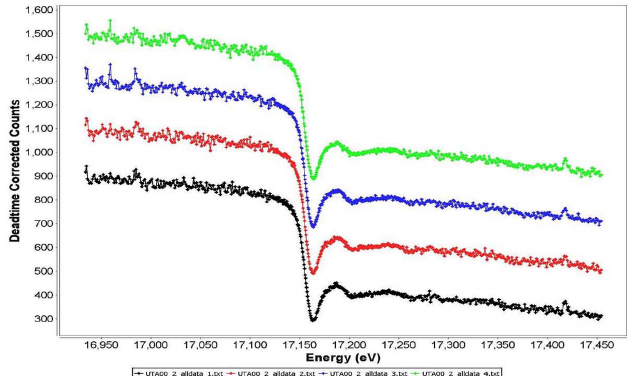
Figure 2 Example of the HERMES plotting window, showing a stack plot of I t data at the U L 3 -edge, separated by a user-specified